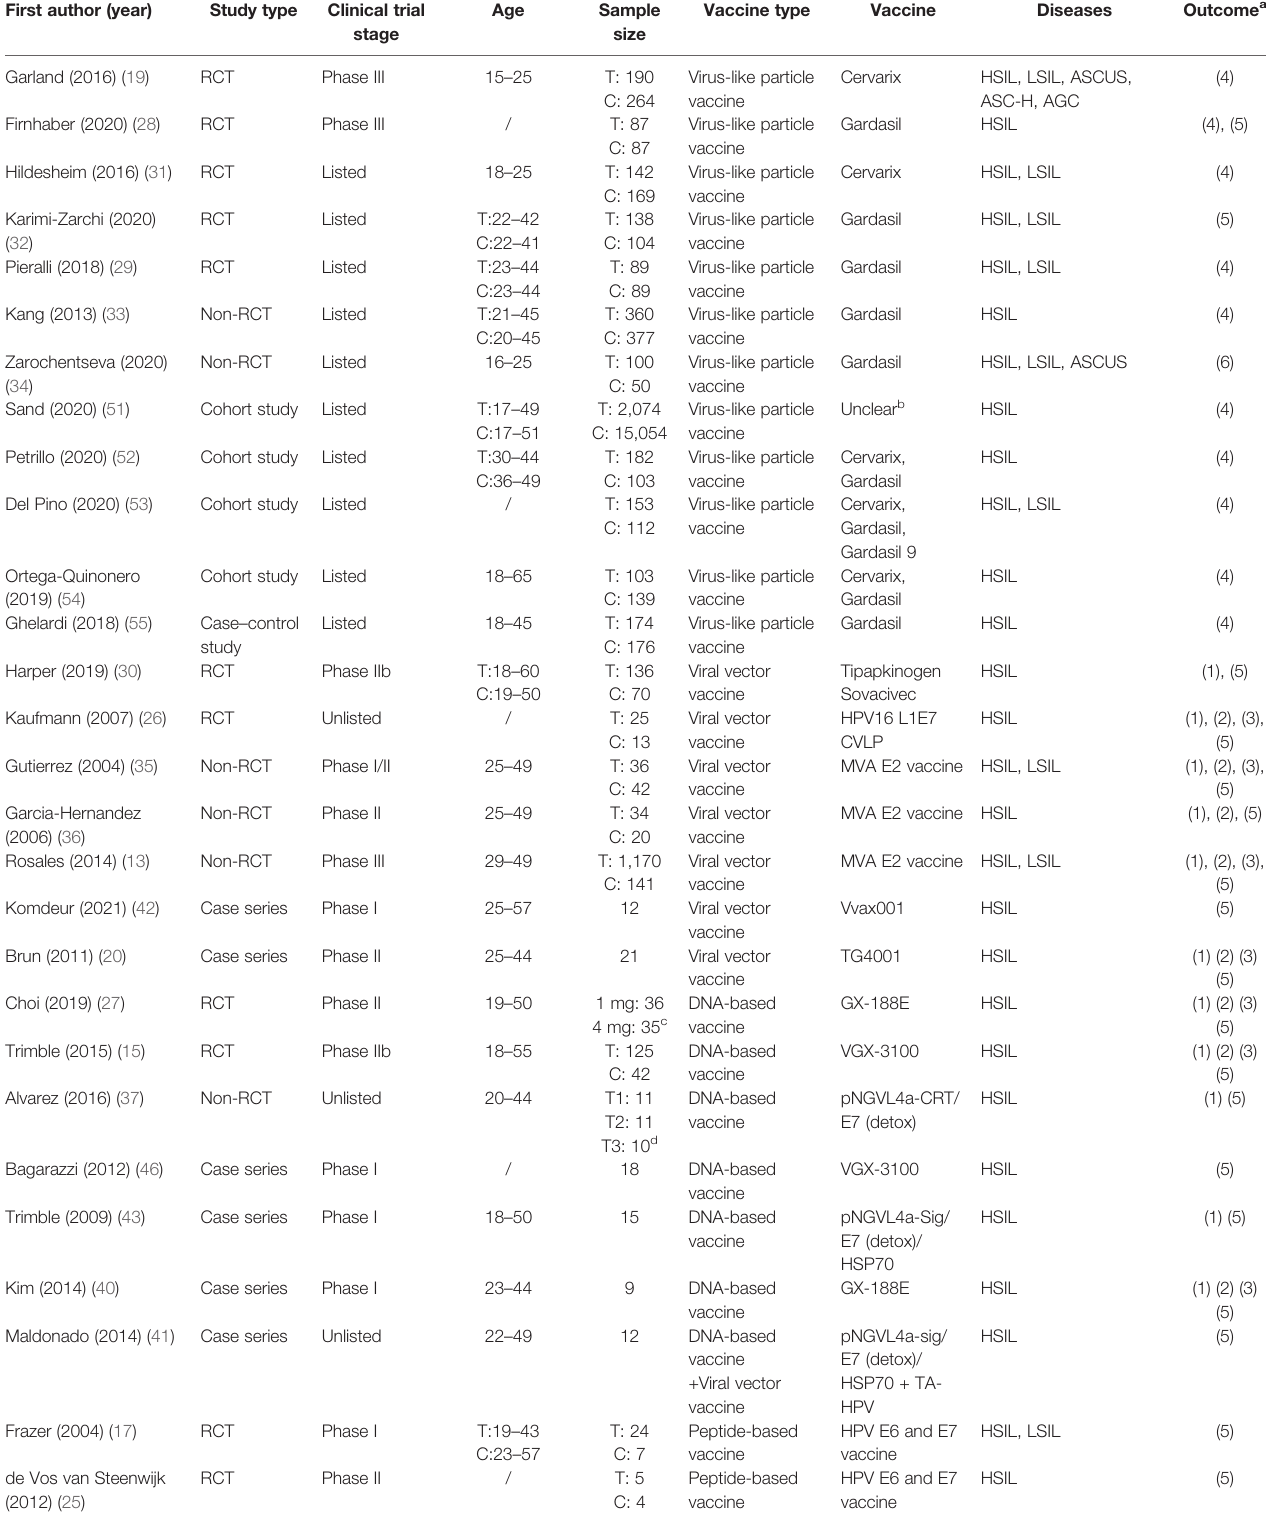
TABLE 1 | Basic characteristics of included studies.